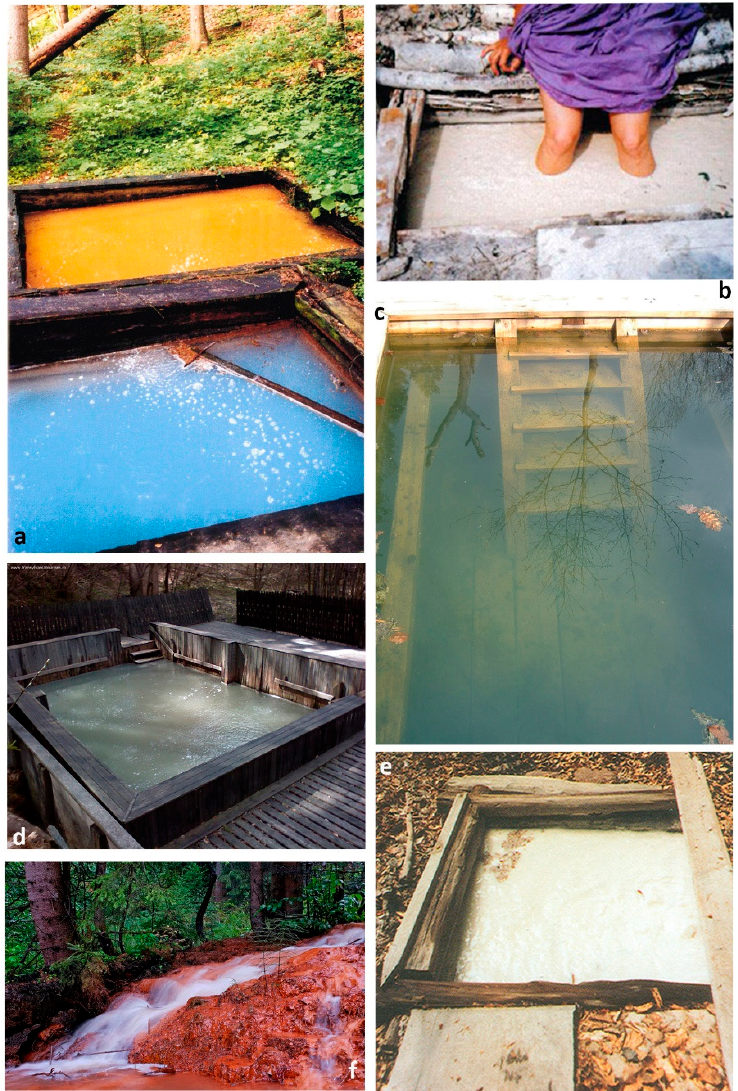
Figure 4. The colours of mineral waters differs depending on their various chemical composition: as far as the high concentration of iron induce a red or yellow coloration ( a ( above ), c , f ), the blue ( a ( below )) and grey ( b , d , e ) tones show the high sulphurosus content of the water. Source: photos by Ars Topia Foundation.